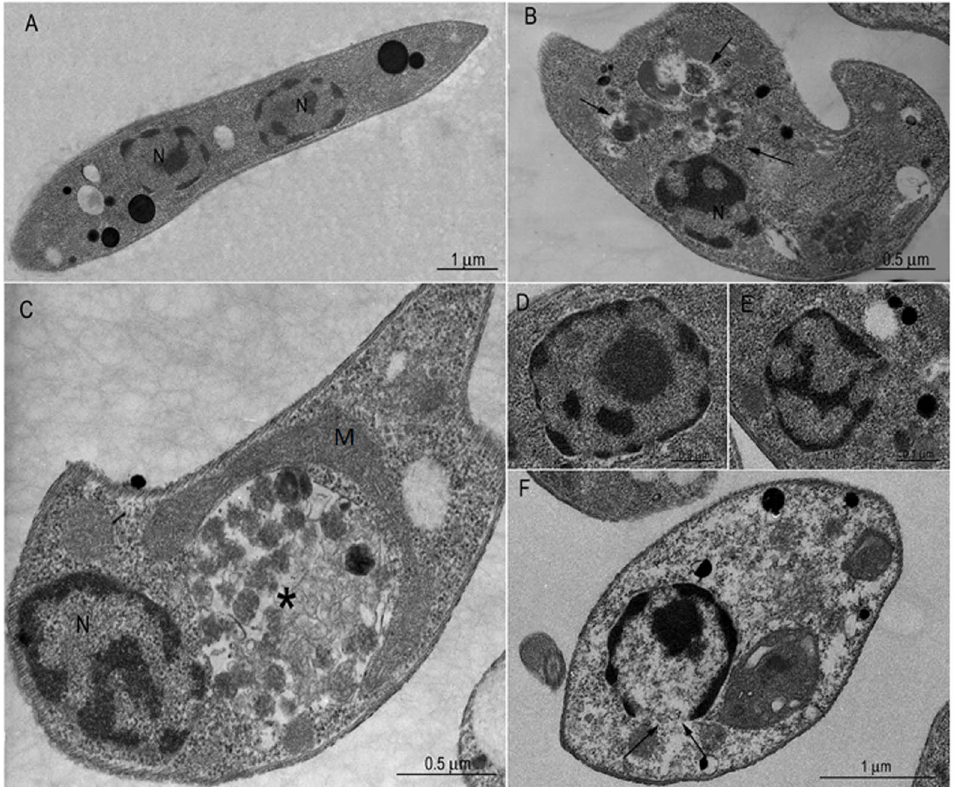
Figure 3. Transmission electron microscopy of Leishmaniaamazonensis promastigotes after treatment with MDL28170. (A) Control, untreated cell: note the elongated body and the normal aspect of the intracellular organelles (N, nucleus). In MDL28170-treated promastigotes both at IC 50 (B–C) and two times the IC 50 (2 6 IC 50 ) doses (D–E), the ultrastructural changes show intense vacuolization in the cytoplasm (arrows in B), disorganization of compartments of the endocytic pathway containing multivesicular bodies-like vesicles (C, asterisk), altered chromatin condensation pattern (D–F) and apparent loss of nuclear integrity (F, small arrows). M, mitochondrion.